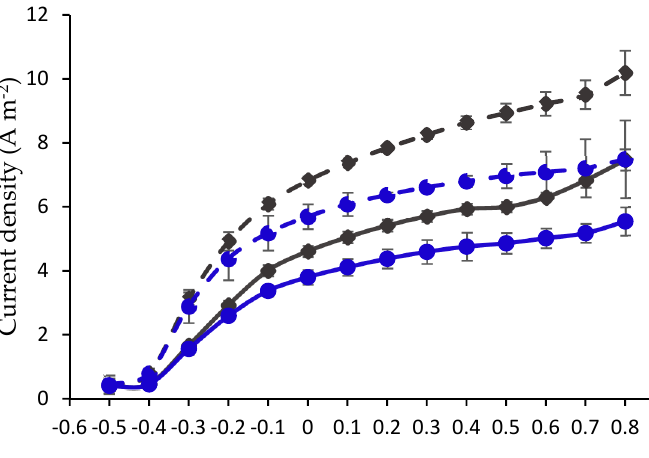
Figure 2. Differential Pulse Voltammetry (DPV) measurement of oxidation currents under 14 steps of applied voltages from − 0.5 V to 0.8 V vs. Ag/AgCl (each step lasted 600 s), in MECs based on different anodes: CC ( ), COMB ( ).